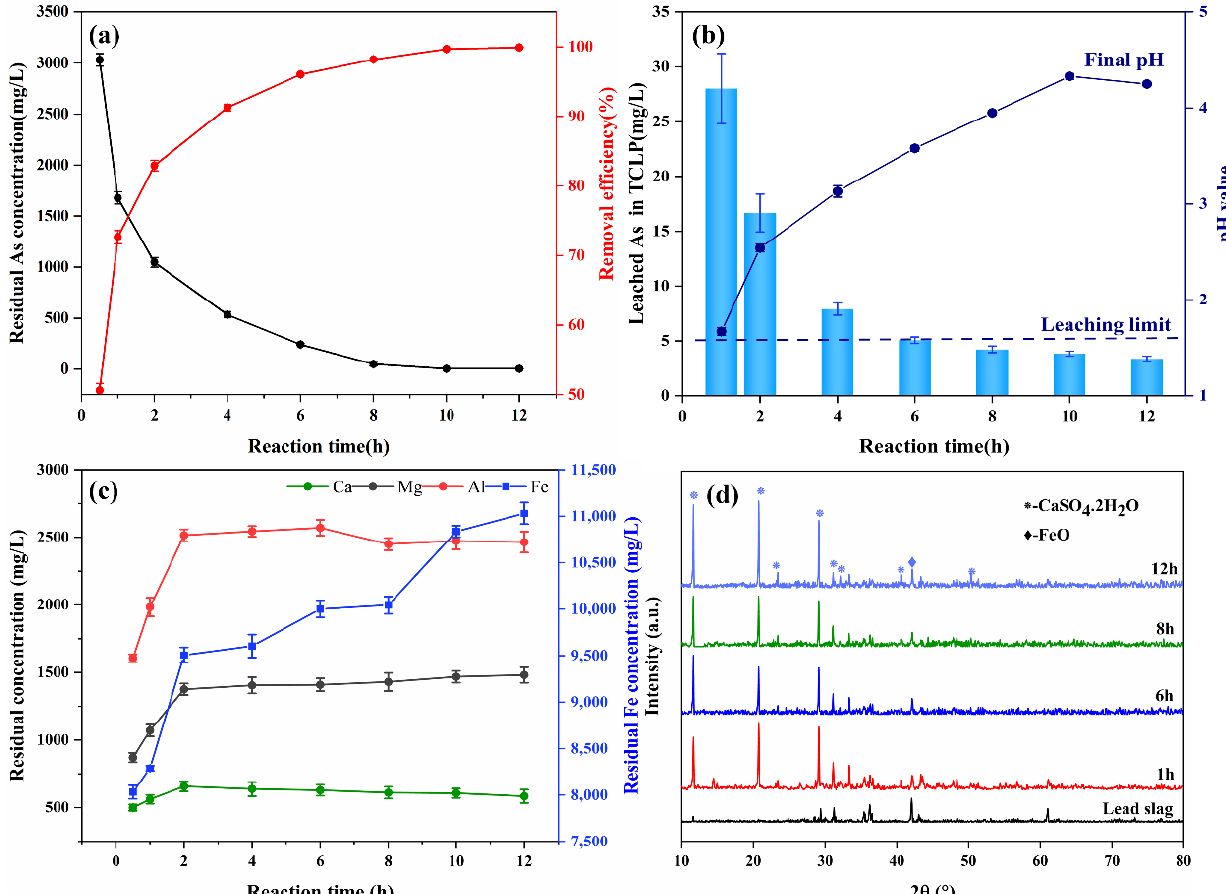
Figure 5. Variations of residual concentration and removal efficiency of As ( a ), leached arsenic concentration in TCLP and final pH value of wastewater ( b ), Variations of concentration of Ca, Mg, Al, Fe ( c ), XRD pattern of the arsenic-loaded precipitates obtained from bath experiments at reaction time of 1, 6, 8, and 12 h (solid–liquid ratio of 1:10) and lead slag ( d ). The quick period of reaction was 0–2 h, during which the dissolution of alkaline oxide raised the pH of wastewater to 2.54, and a large amount of iron, calcium, and